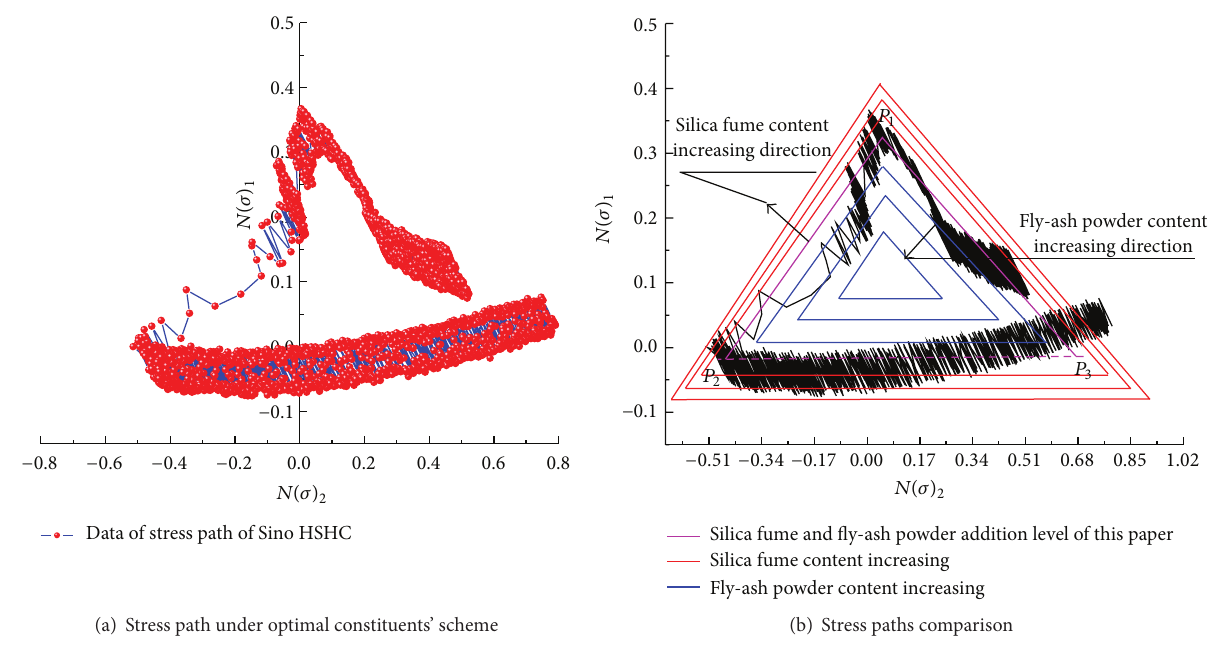
Figure 19: Concrete stress paths characteristics